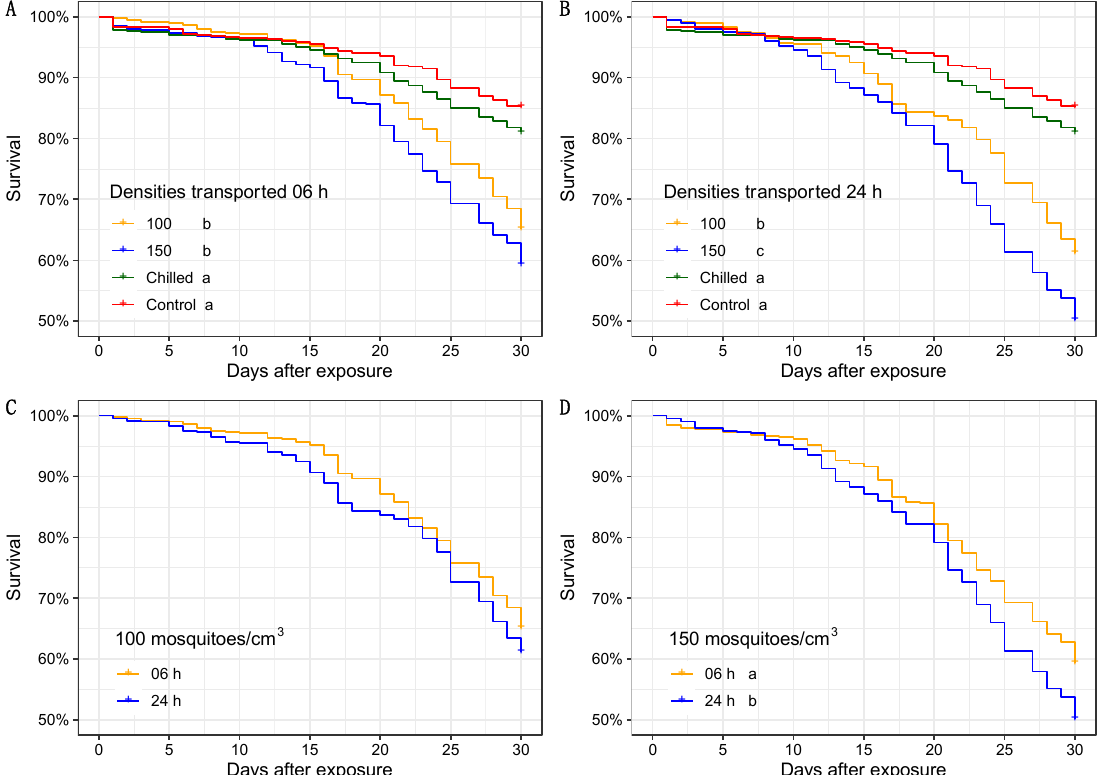
Figure 3. Kaplan–Meier survival curves of compacted and control males over 30 days: ( A ) Chilling and compacting effect for 6 h; ( B ) Chilling and compacting effect for 24 h; ( C ) Shipment using 100 males/cm 3 after knockout (Log-rank test; p < 0.12); ( D ) Shipment using 150 males/cm 3 after knockout. Differences between treatments in A, B and D are represented by different letters (Log-rank test; p < 0.05) T = 27 ± 1 °C; RH = 60 ± 10%, photoperiod = L12:D12. The mean proportion of mated females ranged from 40 to 66% for all treatments. The 6 h shipment interval did not show statistical significance among all tested groups (Kruskal–Wallis = 7.00; df = 3; p > 0.05). At this 6 h interval, the male insemination propensity was affected only by the highest compaction condition in relation to the control (Wilcoxon–Mann–Whitney = 80.5; p = 0.019—Figure 4A). Regarding the shipment interval (6 h and 24 h) the 100/cm 3 density showed no statistical difference (Wilcoxon–Mann– Whitney = 49.5; p = 0.152), as well as the 150/cm 3 density (Wilcoxon–Mann–Whitney = 53; p = 0.075—Figure 4B). Males compacted at 100/cm 3 for 06 h were able to inseminate a similar proportion as the one found in the untreated (Wilcoxon–Mann–Whitney = 64; p = 0.288—Figure 4A). The analysis of the densities (100 and 150 males/cm 3 ) showed that a higher density independent of the shipment interval negatively impacted the percentage of inseminated females (Wilcoxon–Mann–Whitney = 209.5; p < 0.05). The spermatheca replenishment level was determined as partially and fully insemi- nated rates of all inseminated females, as presented in Figure 5. For the 06 h shipment, the insemination pattern was shifted and had a statistical difference between the two densi- ties assessed for partially inseminated females (Wilcoxon–Mann–Whitney = 84.5; p < 0.05, Figure 5). Interestingly, the 24 h shipments did not show this observed insemination pattern shift (Wilcoxon–Mann–Whitney = 36.5; p = 0.119—Figure